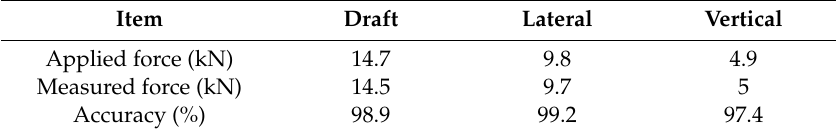
Table 2. Specific result of the static load test for six-component load cell